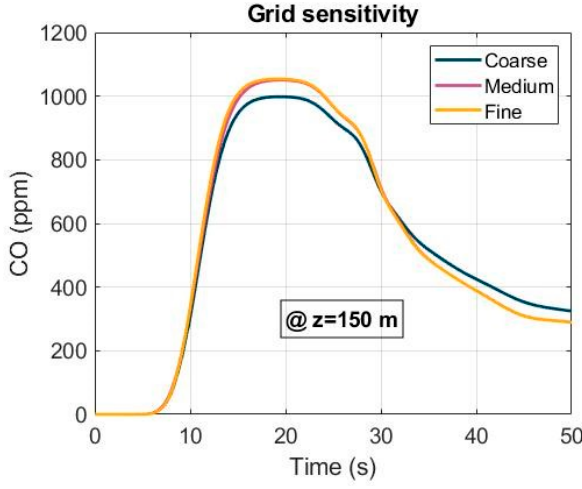
Figure 6. Grid sensitivity analysis of the CO concentration at Z = 150 m under forced ventilation.